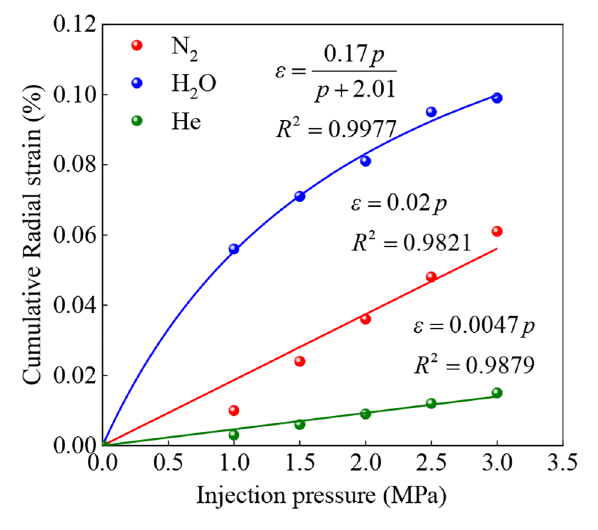
Fig. 4 Cumulative radial strain versus injection pressure